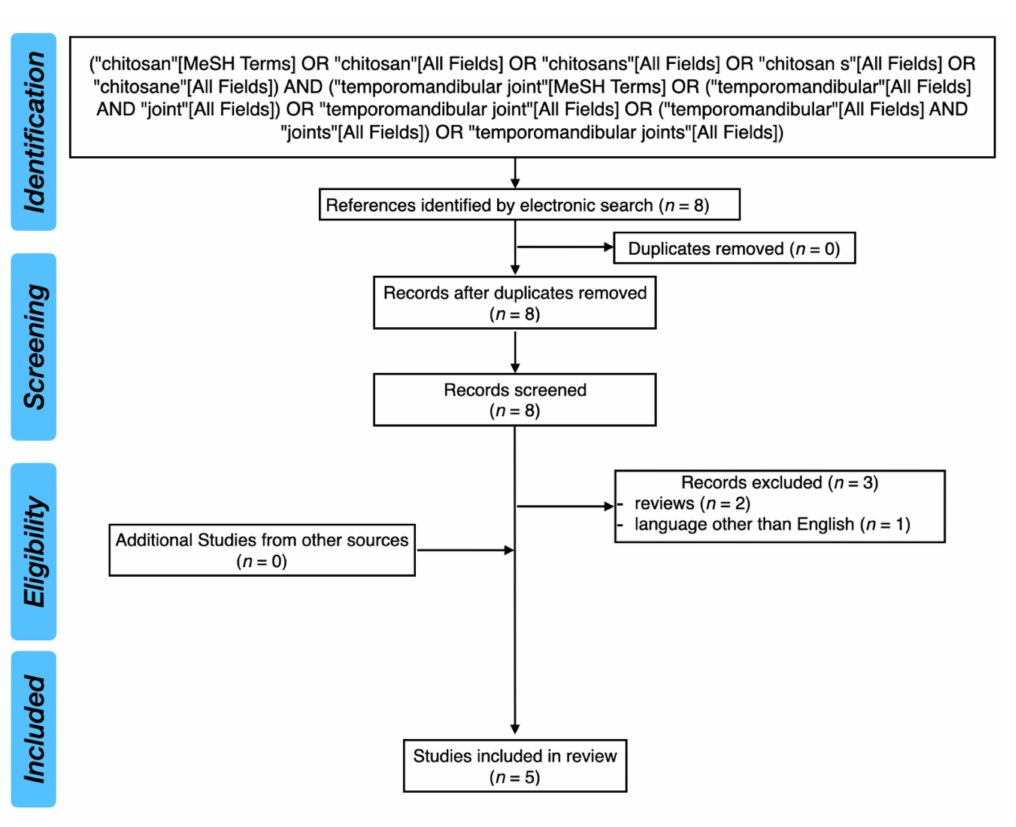
Figure 2. PRISMA flow diagram for the review of the